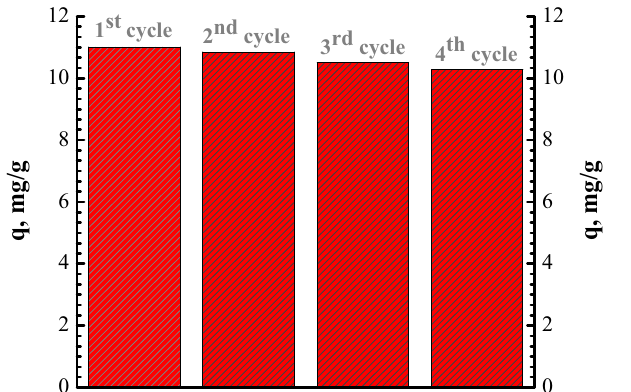
Figure 21. Adsorption capacity in regeneration process.